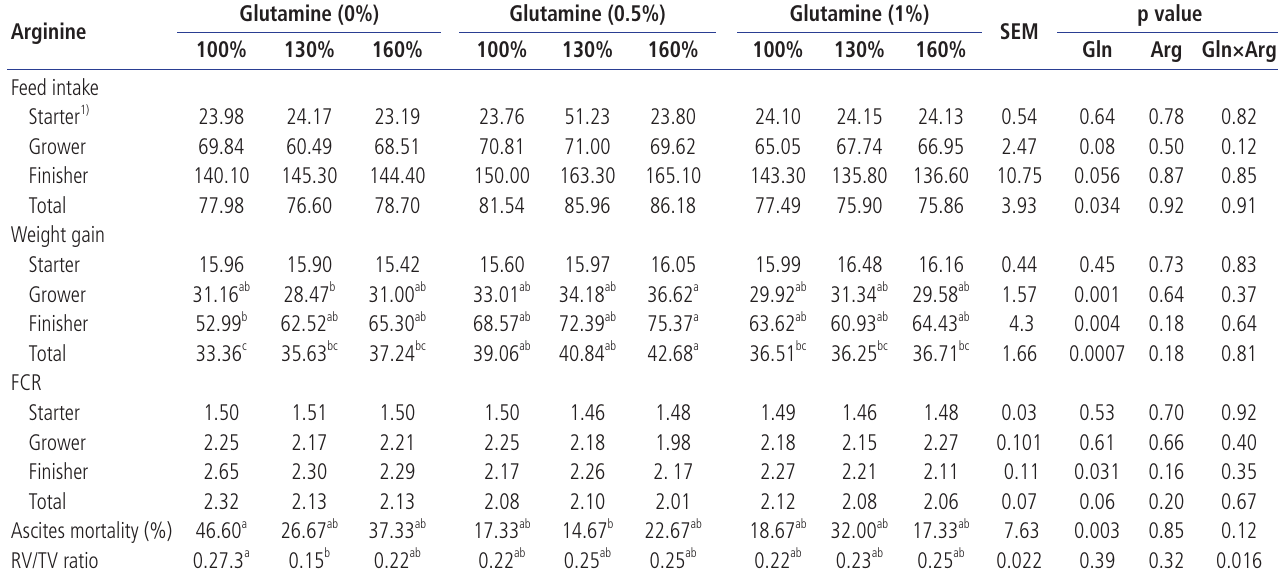
Table 2. The effects of dietary supplementation with glutamine (Gln) and arginine (Arg) on feed intake (g/bird/d), weight gain (g/bird/d), FCR, and mortality ratio in broiler reared under cold environmental temperature (7 to 42 days of